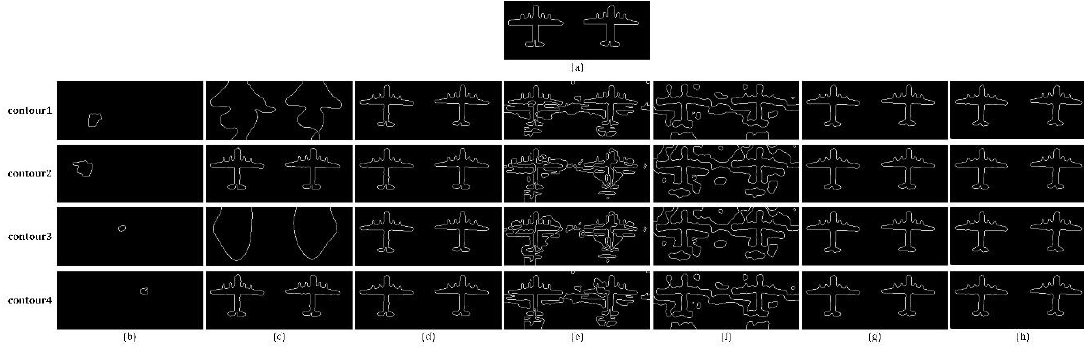
Figure 21. Boundary maps of ‘plane’ image: ( a ) ground truth; ( b ) GAC; ( c ) CV; ( d ) SBGFRLS; ( e ) LBF; ( f ) ILFE; ( g ) Cao’s model; ( h ) the proposed method. Table 6. Statistic of F values (‘man’ and ‘plane’ image), and bold values indicate the top two results.